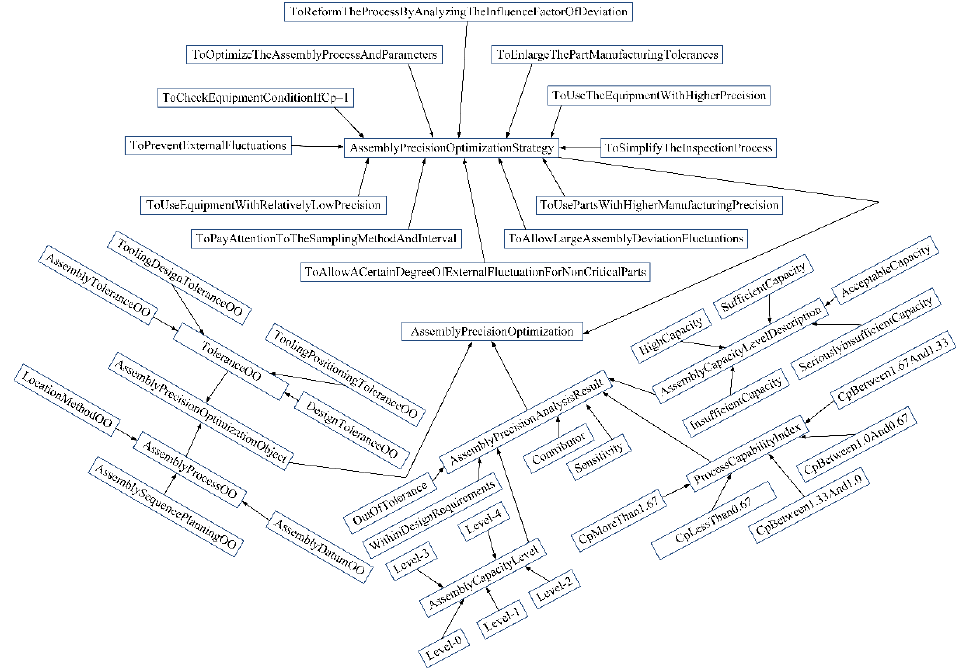
Figure 4. Hierarchy of classes in the ontology model. Table 1. Object properties in the assembly precision optimization